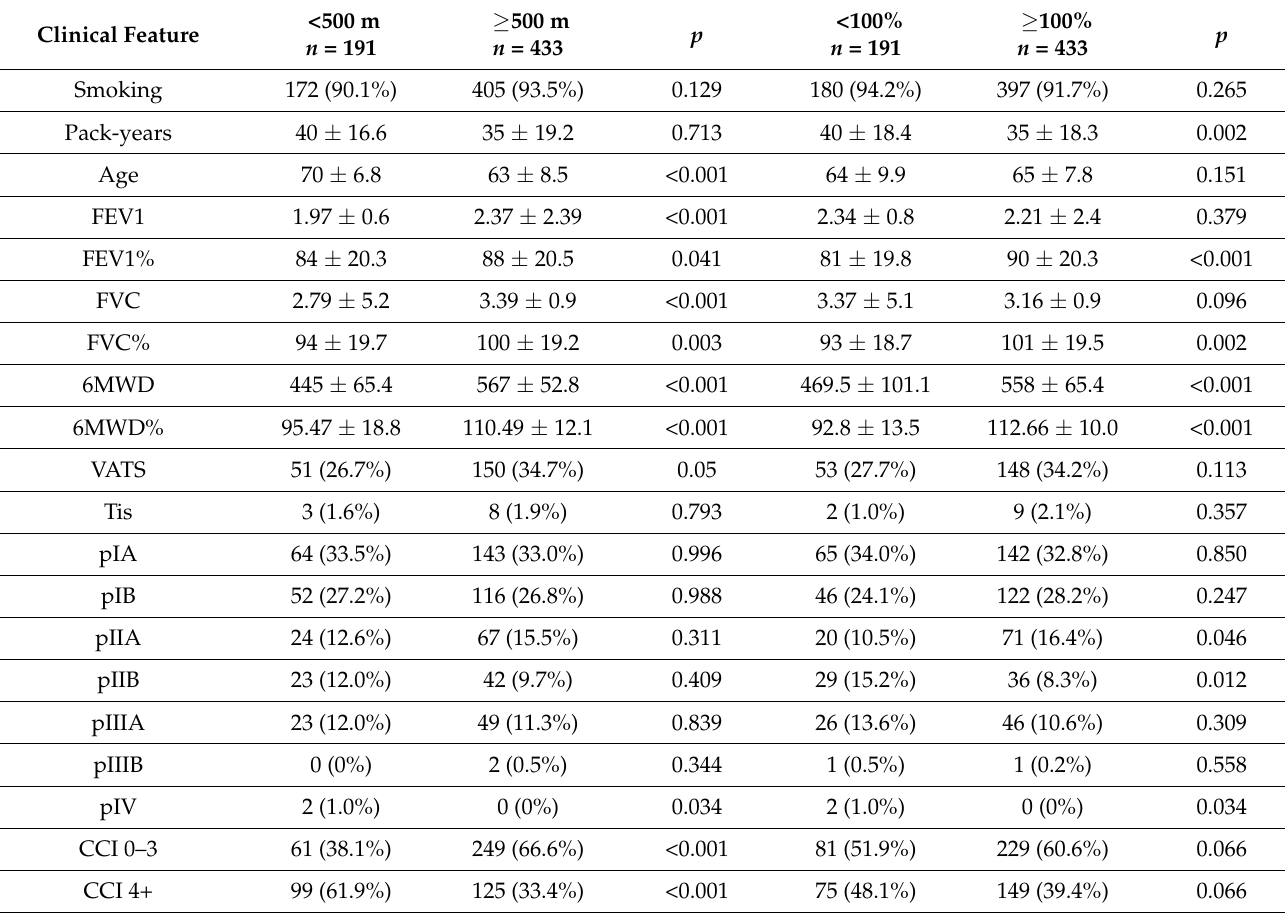
Table 2. Patient characteristics. Patients are divided into two groups depending on the 6-min walk distance (6MWD) and percent of predicted value of 6-min walk distance (%6MWD). The cut-off values are 500 m and 100%,